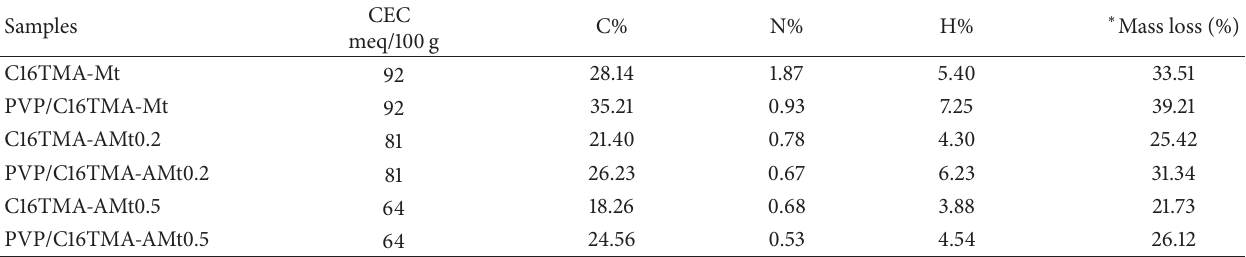
Table 1: C, H, and N analysis (% mass) of different organoclays before and after reaction with PVP solution.